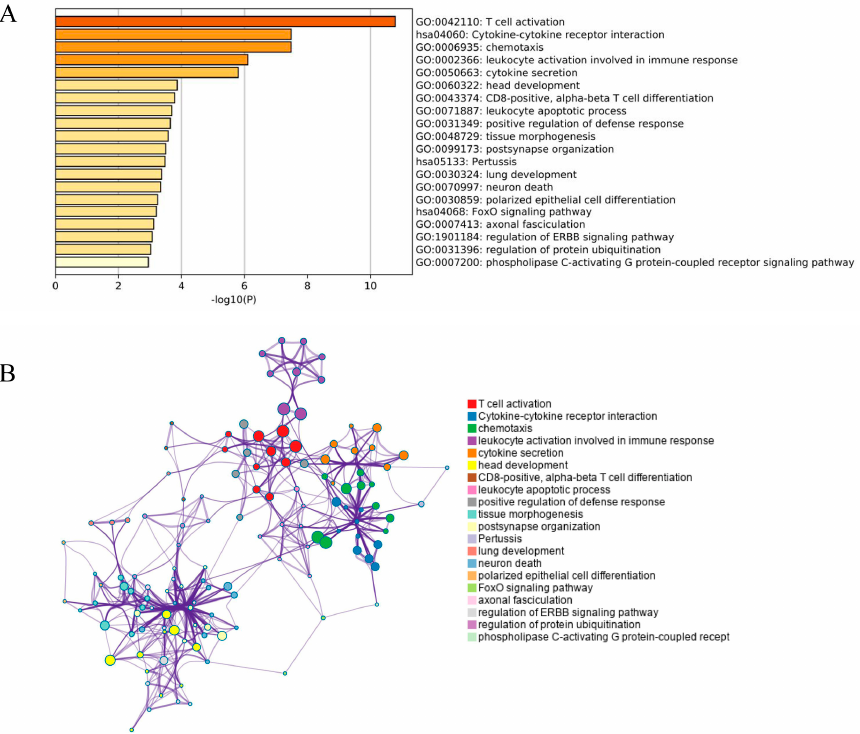
Figure 3. GO and KEGG pathway enrichment analysis of DEGs. ( A ) GO terms and KEGG pathway were presented. ( B ) Network of the enriched terms and pathways.